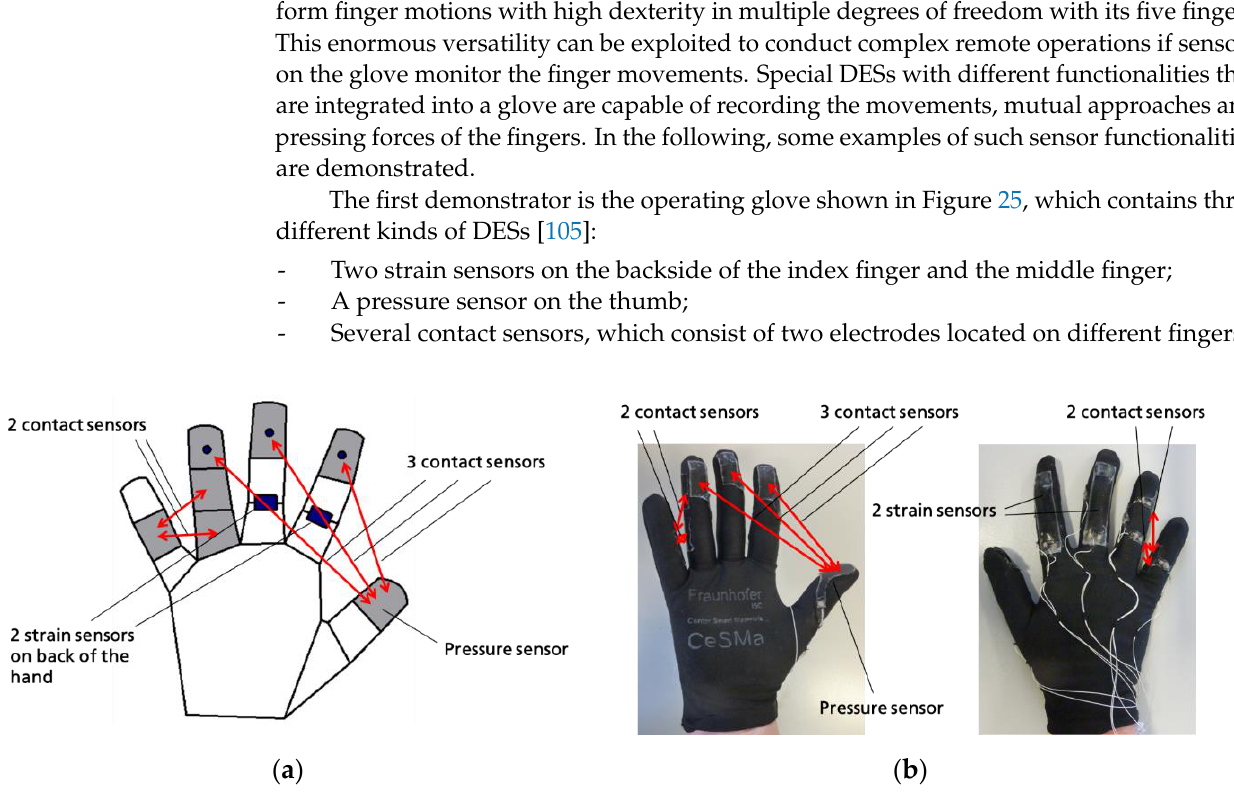
Figure 25. Operating glove with different kinds of DESs. Schematical representation with marked sensor positions ( a ) and demonstrator of the operating glove with sensors on the front side ( left ) and on the back side ( right ) of the hand ( b ) [105].